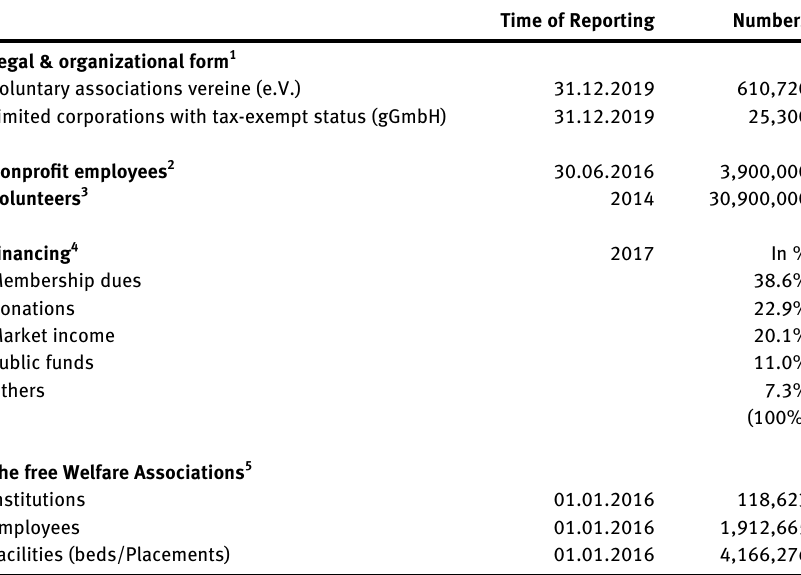
Table  : Key fi gures of the German nonpro fi